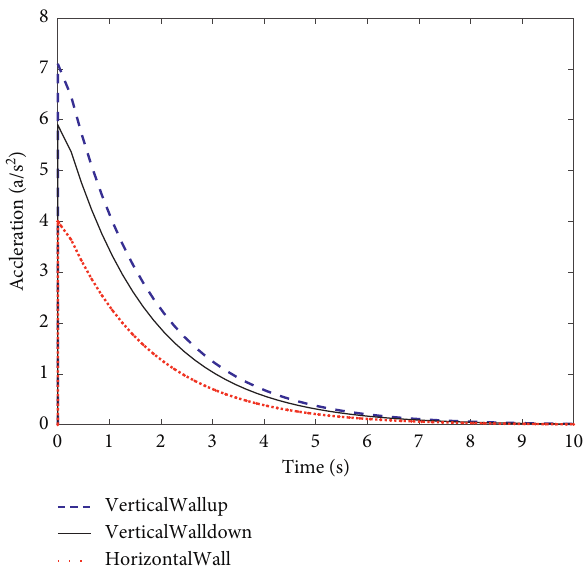
Figure 12: MATLAB/Simulink simulation